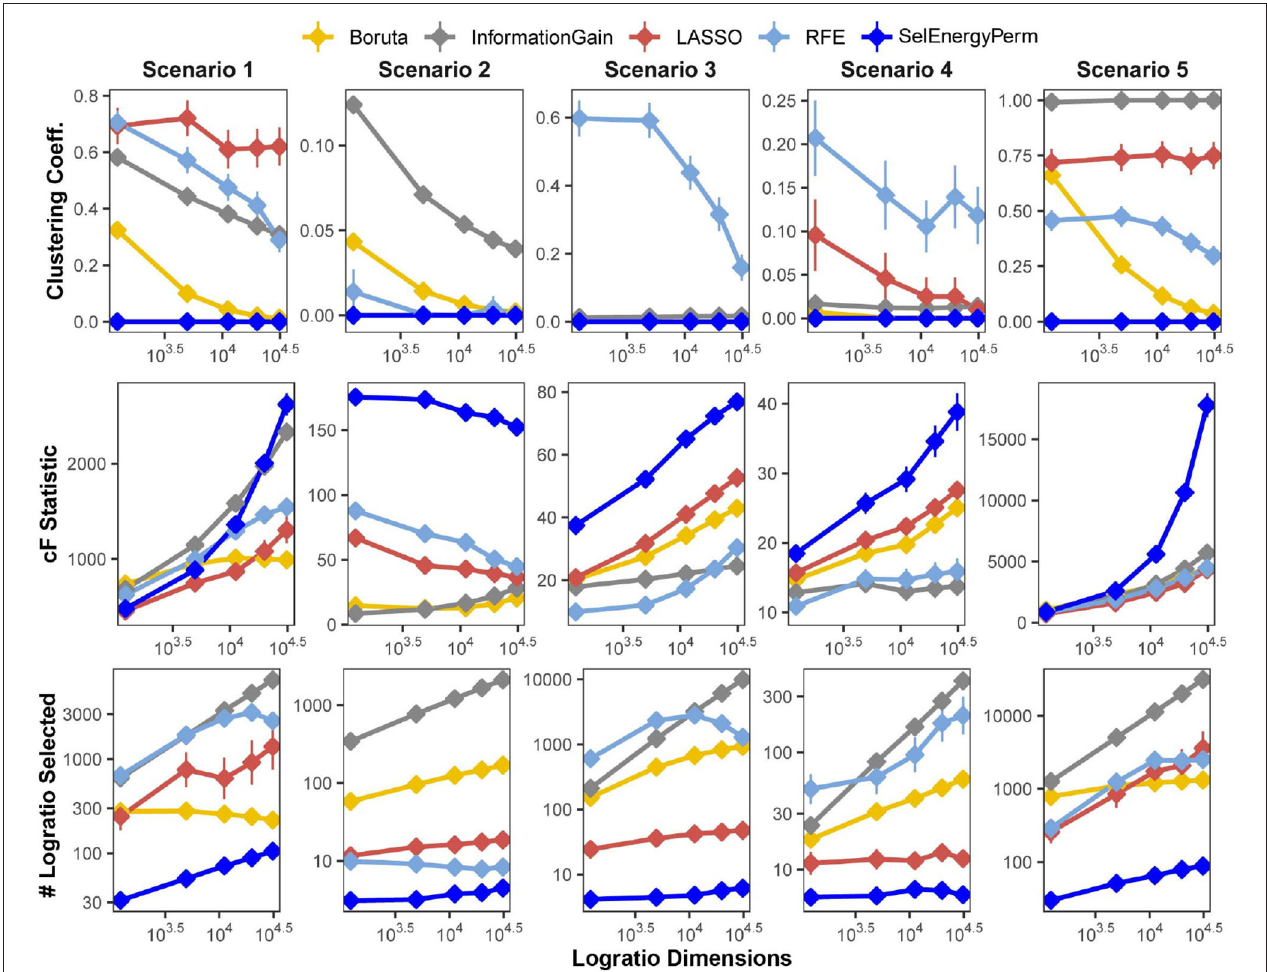
FIGURE 2 | SelEnergyPerm-selected logratio subset characteristics compared with Boruta, Information Gain Filtering, LASSO, and RFE across five simulation scenarios for the balanced sampling design. Using 200 simulations for each scenario-dimension by method we assessed: (Top Row) the clustering coefficient of logratio networks formed by selected subsets returned from each method, (Middle Row) the magnitude of the association as measured by the combined-F ( cF ) statistic on selected subsets returned from each method, and (Bottom Row) the number of logratios returned by each method. Points are the mean for each experimental condition and error bars indicate 95% confidence